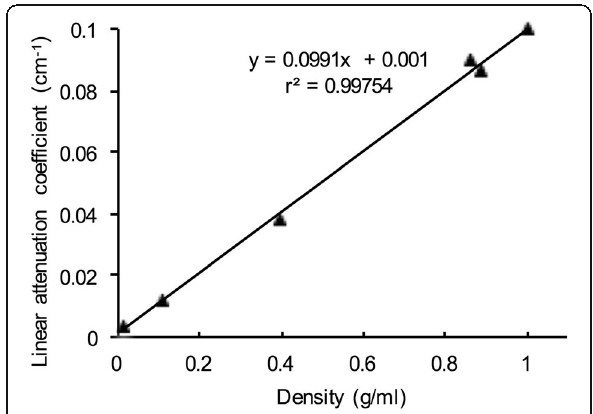
Fig. 2 Correlation between the known density of various phantoms and the linear attenuation coefficient. The regression equation relating the two variables was a linear attenuation coefficient = 0.0991 (density) + 0.001; ( r =